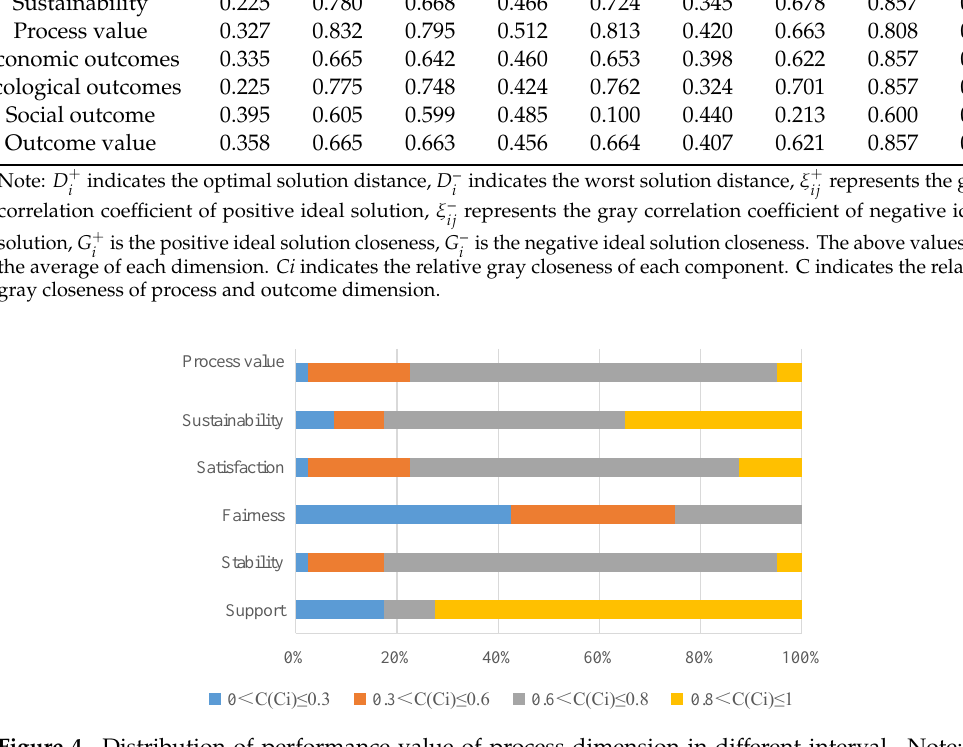
Figure 4. Distribution of performance value of process dimension in di ff erent interval. Note: Ci indicates the relative gray closeness of each component. C indicates the relative gray closeness of process